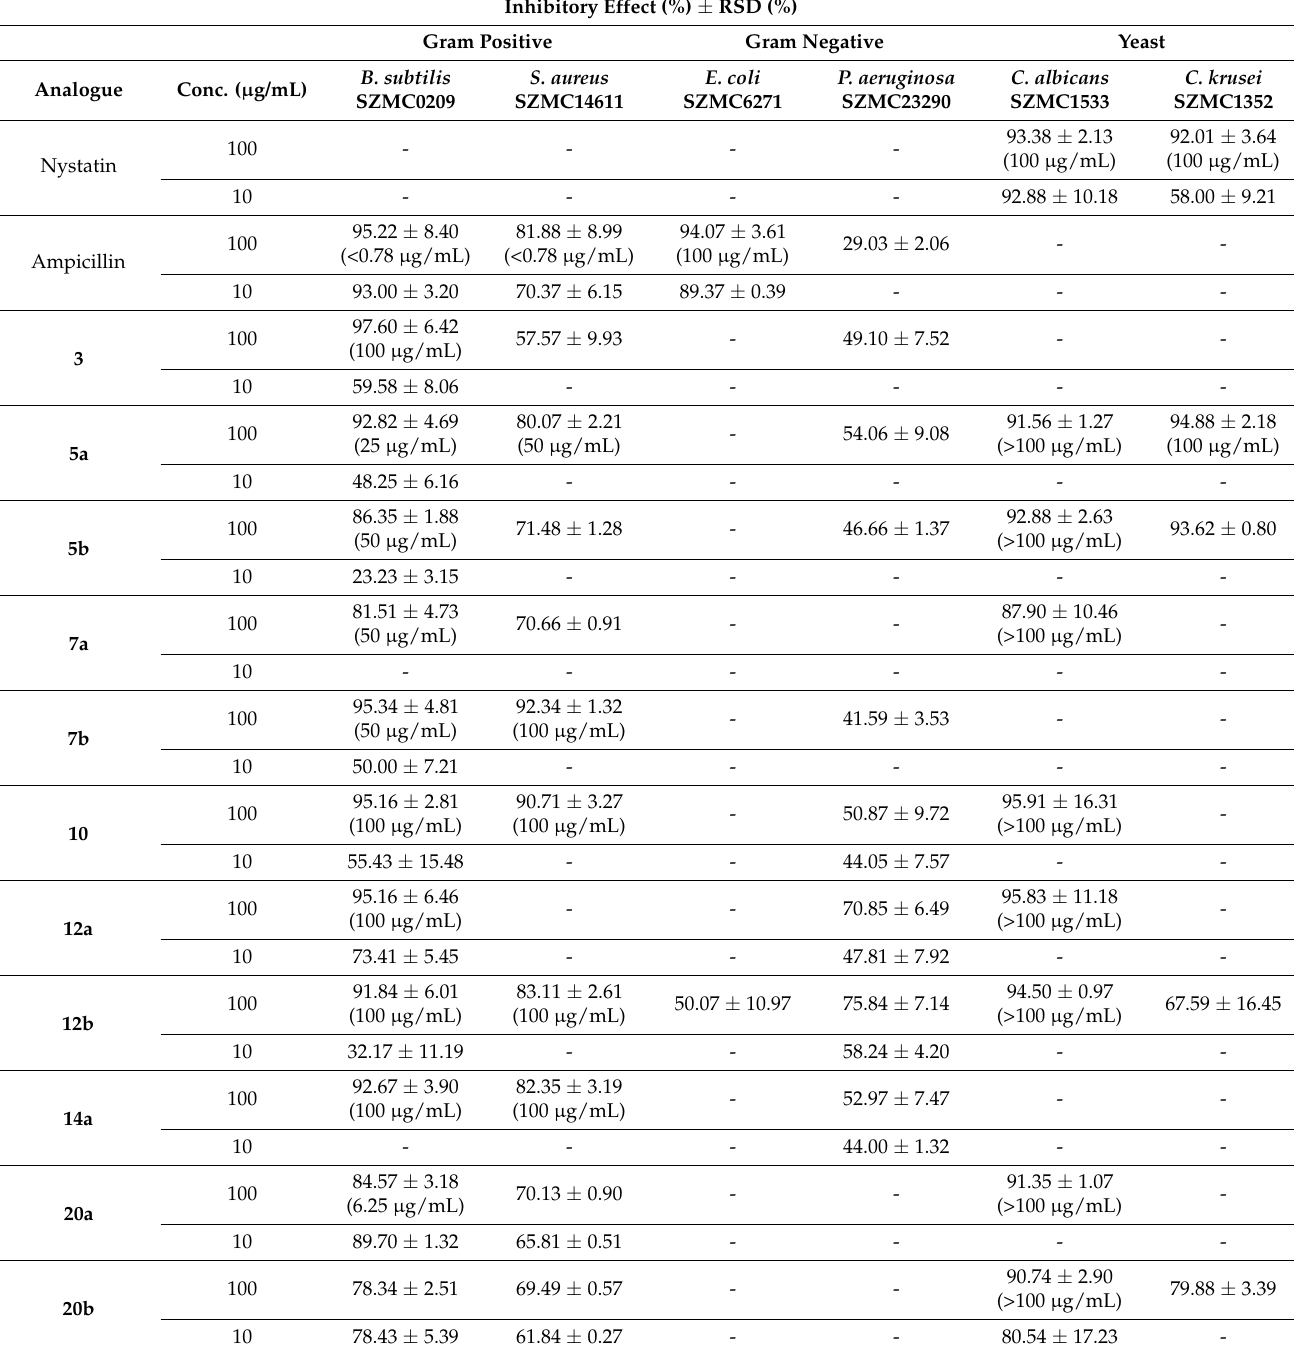
Table 1. Most relevant antimicrobial activity of O -benzyl derivatives expressed as inhibitory effect (%) and MIC values (in